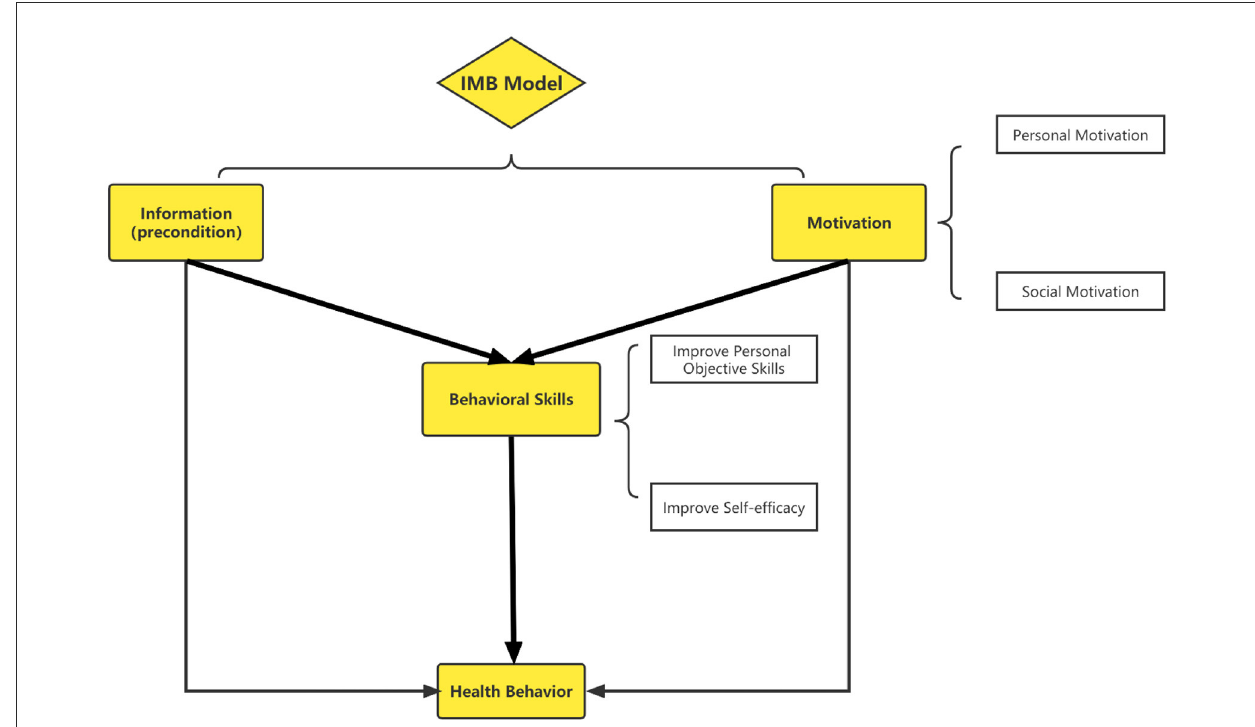
FIGURE1 Conceptual framework of the role of IMB model on health